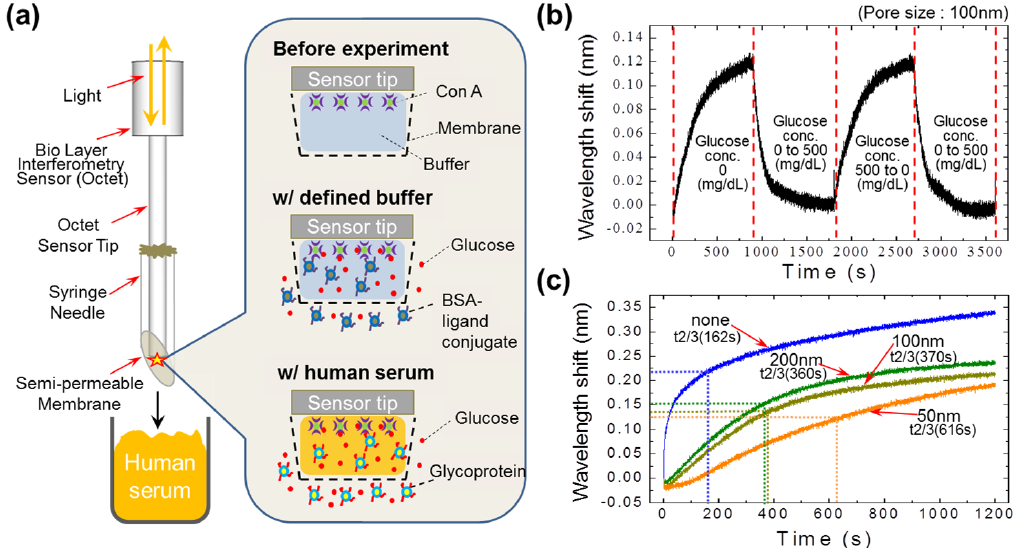
Figure 1. Needle-type sensor performance and the influence of membrane size on the detection of glucose concentrations in defined buffer. ( a ) Schematic of the needle-type sensor. A syringe needle was modified and covered with a semi-permeable membrane to fabricate the needle-type sensor. Bovine serum albumin (BSA)-ligand conjugate was kept outside of the semi-permeable membrane; ( b ) A glucose sensing profile generated by the sensor. The wavelength shift increases with time as the sensor is exposed to the buffer containing the BSA-ligand conjugates, whereas the shift sharply decreases as the sensor is exposed to a solution of 500 mg/dL glucose (with BSA-ligand conjugate); ( c ) Membrane pore-size performance. The response of the sensor increased as the pore size increased from 50 nm to 200 nm. Con A: concanavalin A.